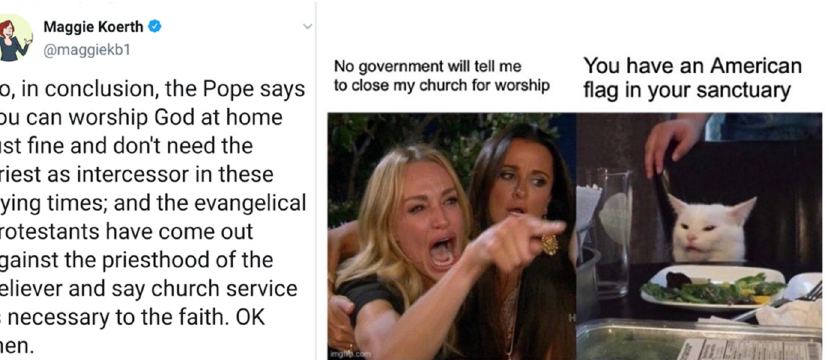
Figure 7. Examples of memes that emphasize church members are against social distancing prac- tices and the contradictions within their justifications for their